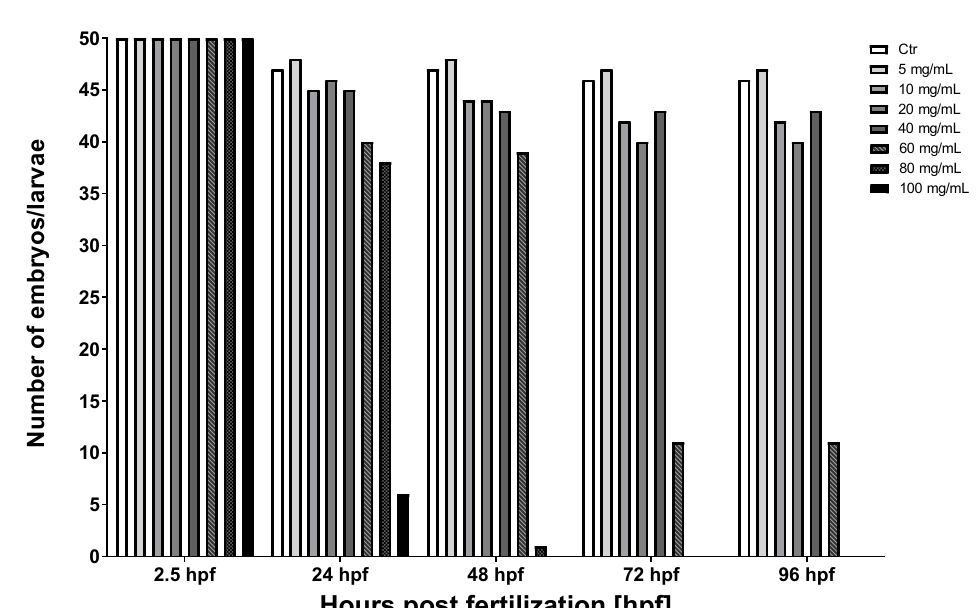
Figure 2. Results of the effect of MI on the zebrafish survival. Ctr–control group; zebrafish embryos were treated by elevating concentrations of MI solutions from 5 to 100 mg/mL. Effect of different concentrations of MI were observed after 24, 48, 72, and 96 h post-fertilization (hpf).